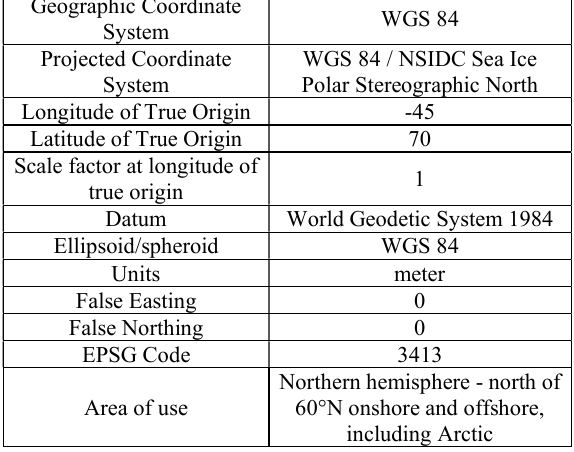
Table 1 . Attributes of WGS 1984/NSIDC Sea Ice Polar